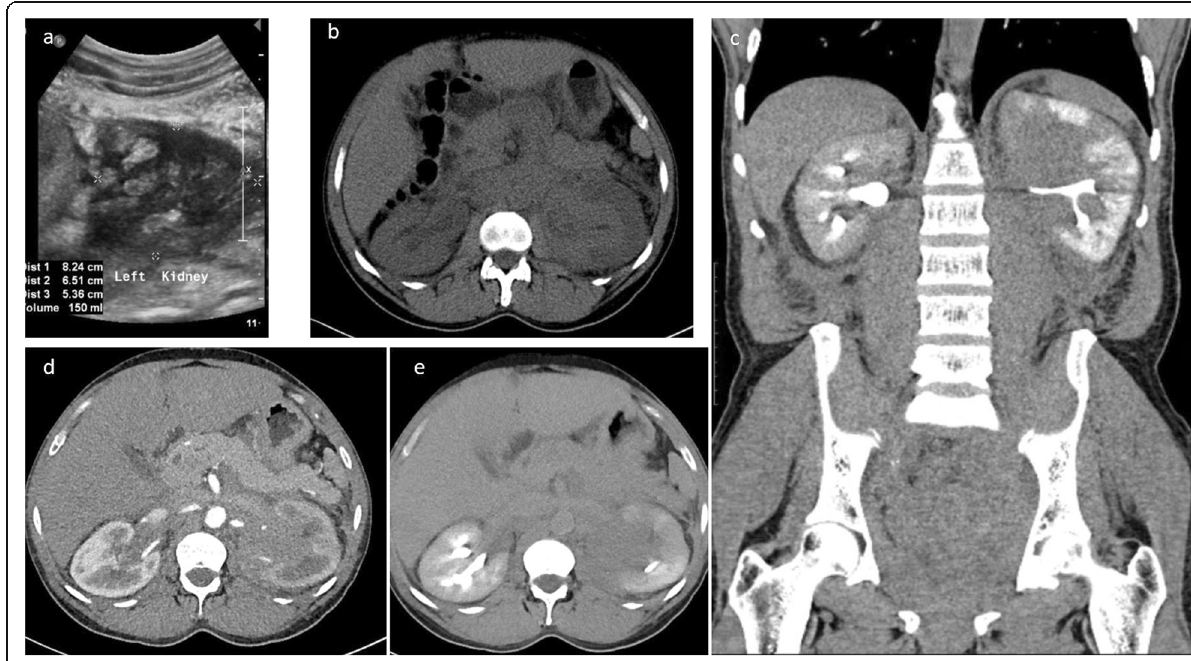
Fig. 5 Ultrasound image of the left kidney in a HIV-positive male demonstrates heterogeneously echogenic areas in the medulla extending to the collecting system. Unenhanced CT KUB showed diffuse thickening of the renal pelvis with hyperdense soft tissue material relative to the renal parenchyma. Heterogenous infiltration of the kidney is seen on the postcontrast CT images in arterial and urographic phases